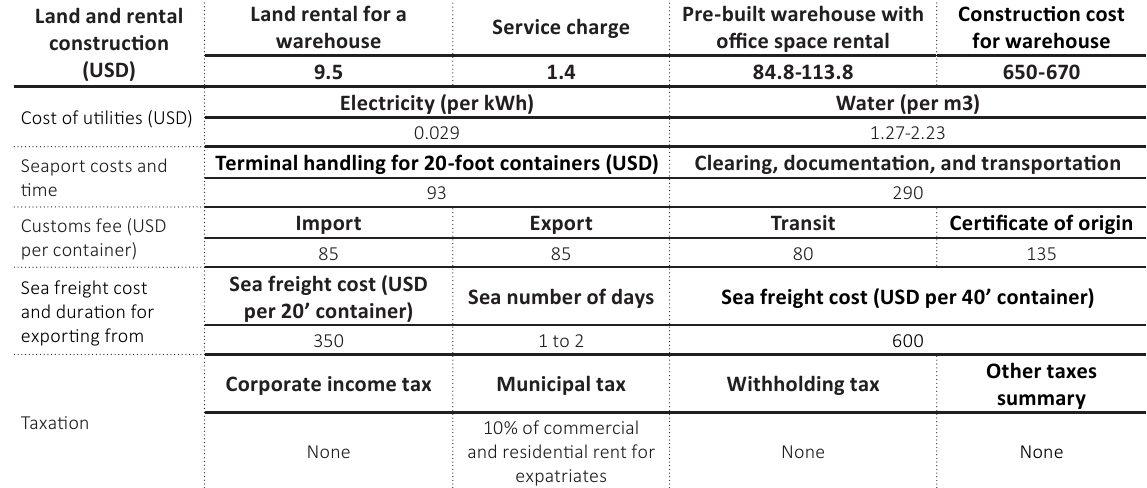
Figure 3. Total annual manpower cost in USD for logistic company Table 1. Infrastructure, utilities, and other facilities for startups in Bahrain Source: Ministries of Commerce and Industry, Water and Municipality, KPMG research and